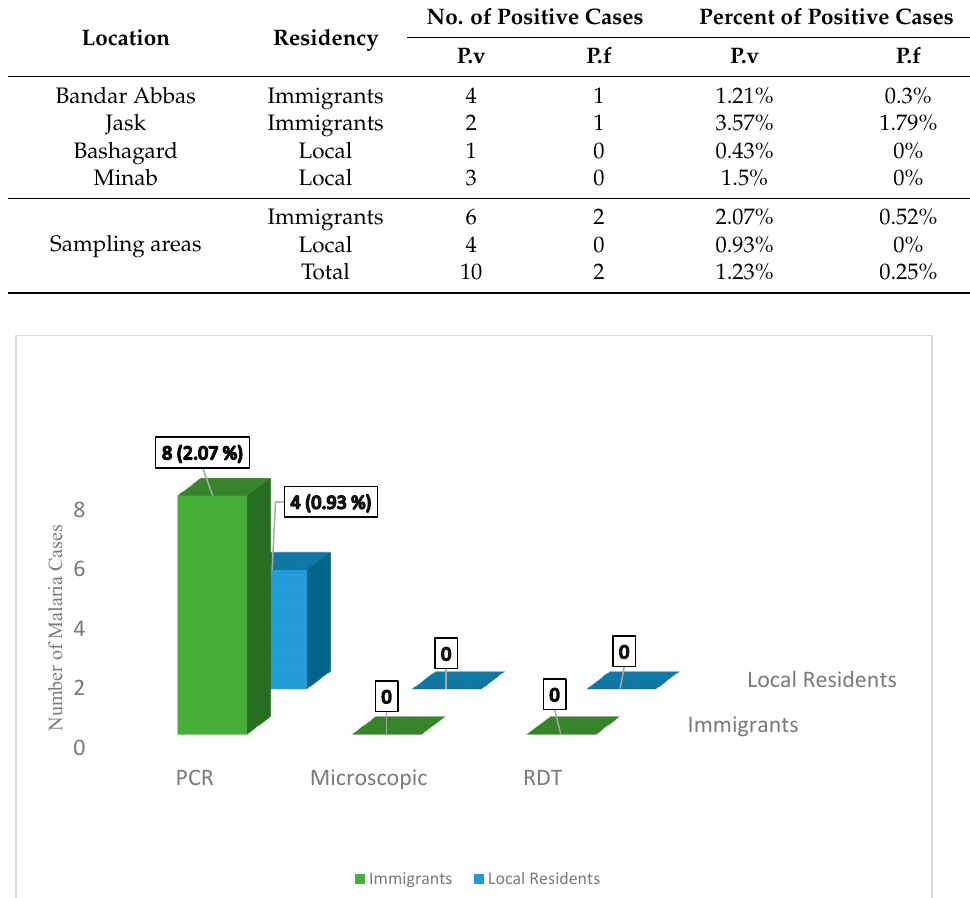
Table 5. Positive malaria cases detected by PCR according to parasite species, location, and residency in an asymptomatic malaria study.